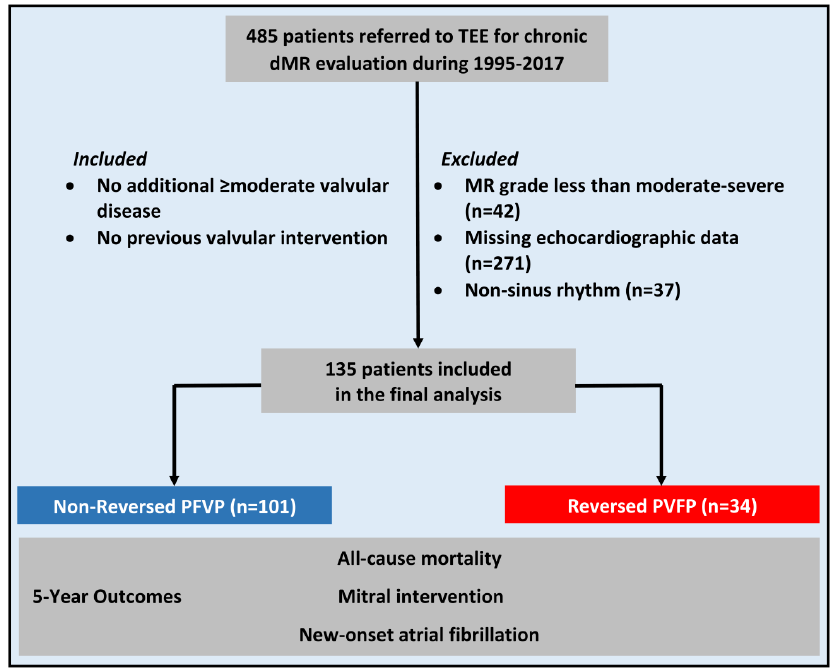
Figure 2. Study Flow Chart. dMR = degenerative mitral regurgitation; LV = left ventricle; NSR = normal sinus rhythm; PVFP = pulmonary venous flow pattern. Baseline clinical and echocardiographic characteristics of the study cohort are pre- sented in Tables 1 and 2, respectively. Notably, the patients were mostly male (n=93, 68.9%) and the median age was 68 (IQR, 58-74) years. Additionally, more than half (n=70, 56.5%) were hypertensive. MR was concluded as severe in 89 (65.9%) cases and prolapse mainly involved the posterior leaflet alone (n=94, 69.5%), followed by both leaflets (n=26, 19.3%) and the anterior leaflet only (n=15, 11.1%). Table 1. Baseline Clinical Characteristics of the Study Population.